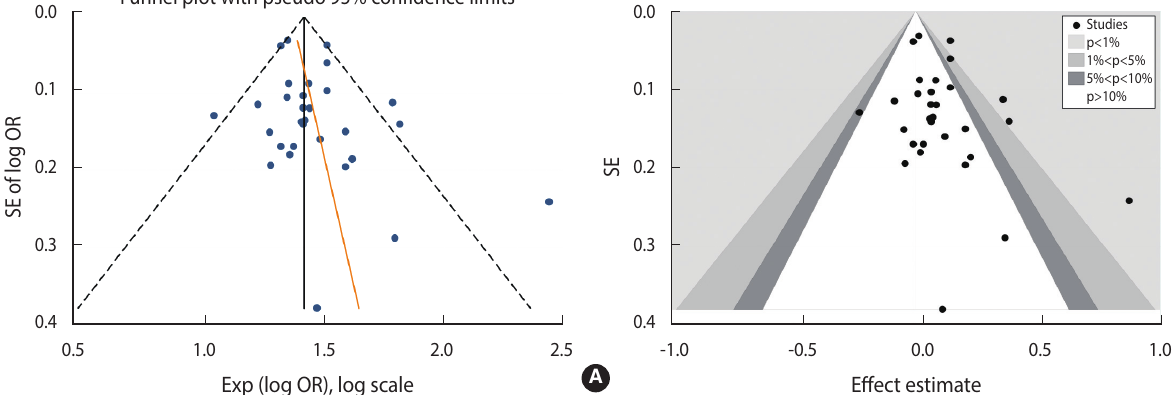
ratio.Exp Figure 6. (A) meta-funnel and (B) counter-enhanced funnel with pseudo 95% confidence intervals to detect publication bias on the effect of antiretroviral therapy on congenital anomalies. SE, standard error; OR, odds